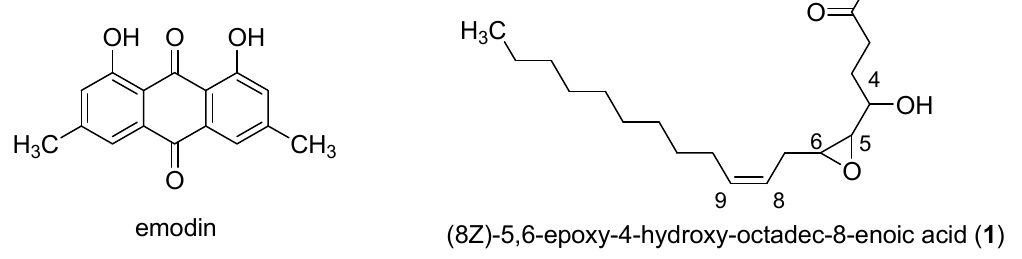
Figure 7. Chemical structures of compounds identified as actives by the FiBiCo script. Emodin was biosynthezised by Coniochaeta species and the fatty acid was isolated from Preussia persica extracts.